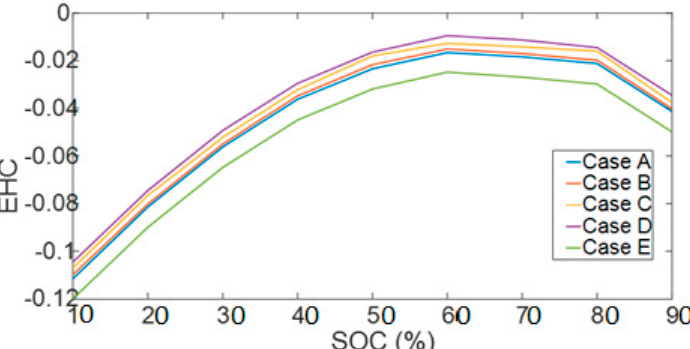
Figure 5. Entropic heat coefficient (EHC) (mV/°C) of the battery as a function of state of charge.